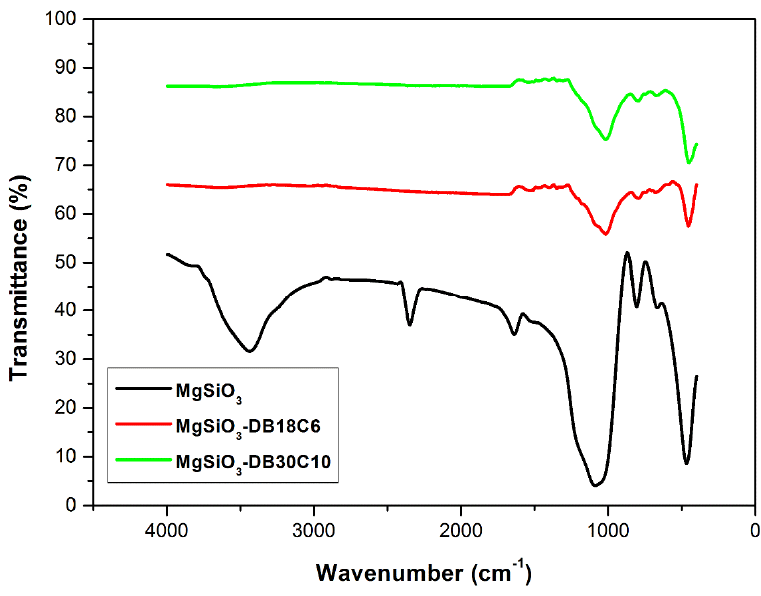
Figure 3. FT-IR spectra of MgSiO 3 , MgSiO 3 -DB18C6 and MgSiO 3 -DB30C10.